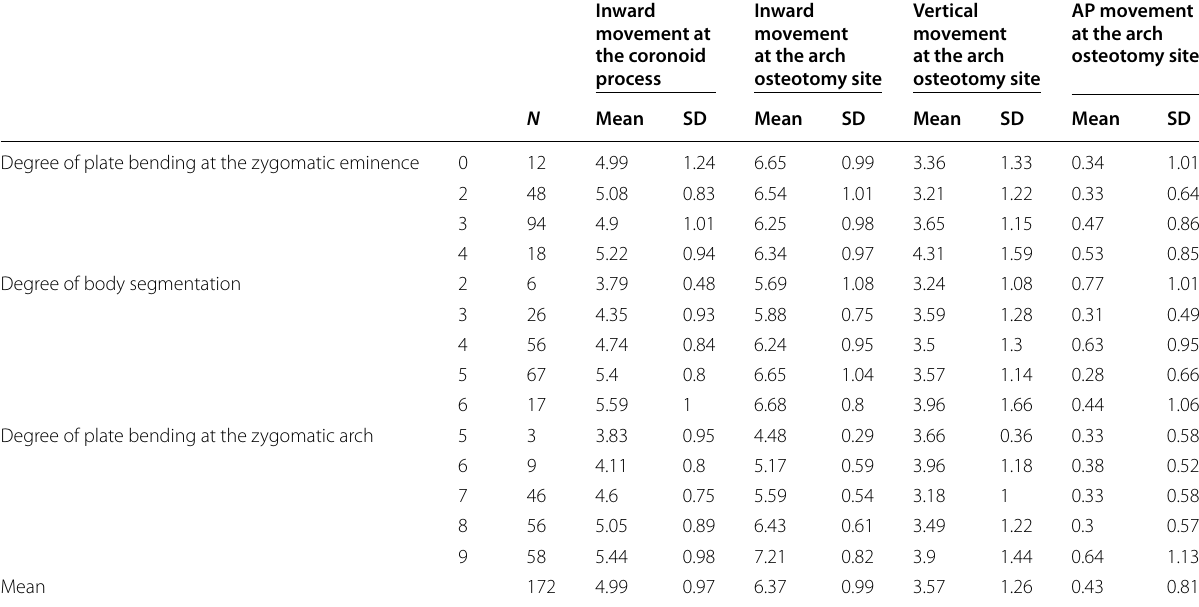
, anterior or upward movement +